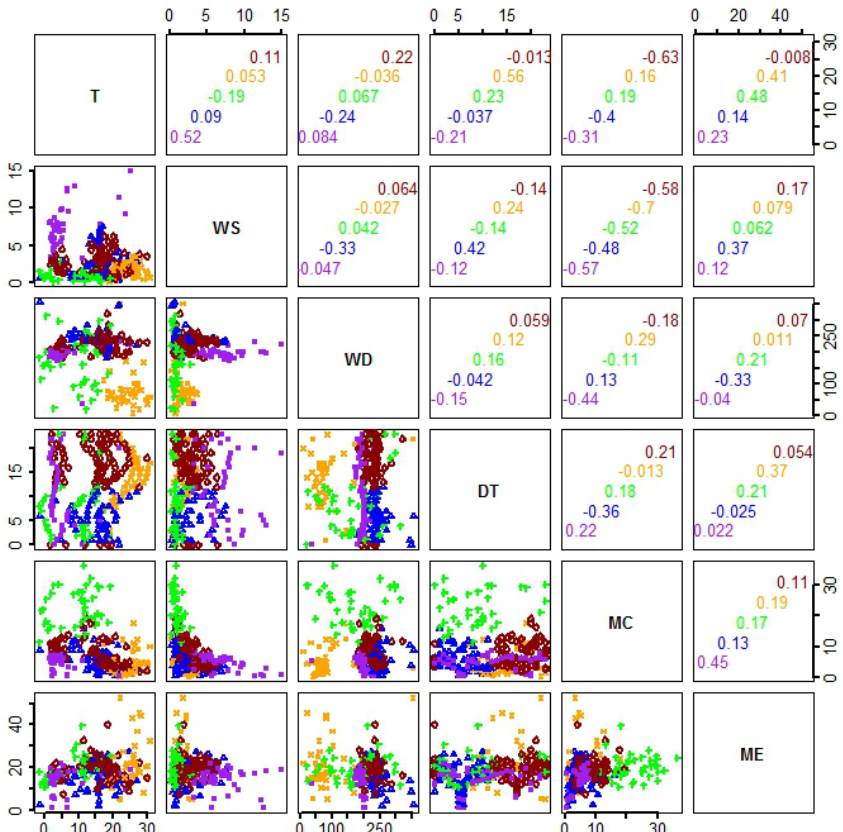
Figure 4. Clustering of air temperature (T) in ◦ C, wind speed (WS) in ms − 1 , wind direction (WD) in ◦ , daytime (DT) in h, CH 4 concentration (MC) in ppm and CH 4 emission (ME) in gh − 1 LU − 1 in the data set of the slatted floor system in Switzerland. The abbreviations on the diagonal indicate which variables are displayed at the axes in the respective row and column of the plot. Cluster affiliation is color-coded in the scatter plots in the lower triangle in violet, blue, green, orange and red (ordered from low median of emission to high median of emission in the cluster). The upper triangle shows the related Spearman’s rank correlation values for the individual clusters in the same